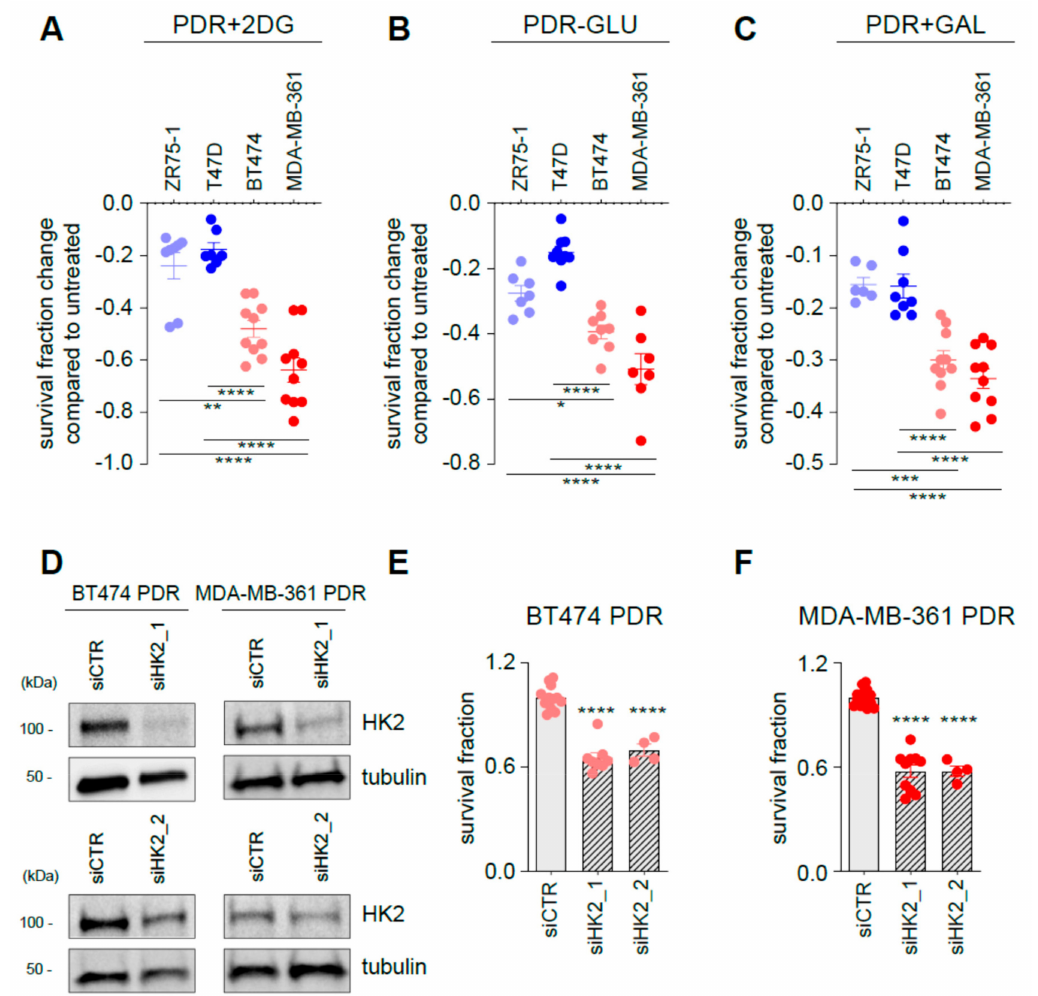
Figure 5. Targeting glycolysis resensitizes ER + / HER2 + PDR cells to palbociclib. PDR cells were either treated for 3 days in the presence of 2-DG ( A ), glucose-deprived medium ( B ) or in a medium in which glucose is replaced by galactose ( C ). Data are presented as fold change survival fraction of treated versus vehicle-treated or basal-cultured cells. Each dot represents at least three technical replicates from three biological replicate. Shades of blue dots are for HER2 − PDR cells, shades of red dots for HER2 + PDR cells. Data represent means ± SEMs and were compared to vehicle-treated or basal-cultured conditions using one-way ANOVA; Dunnett corrected; * p < 0.05; ** p < 0.01; *** p < 0.001; **** p < 0.0001. ( D ) Total protein lysates from ER + / HER2 + PDR cells transfected with the oligos as described in the figure for 72 h were subjected to Western blot analysis, as indicated. ( E , F ) Survival fraction changes were measured in cells transfected as indicated in the Figure. Each dot represents at least three technical replicates from three biological replicates. Data represent means ± SEMs and were compared to non-targeting control siRNA (siCTR)-treated cells using Student t test; **** p <